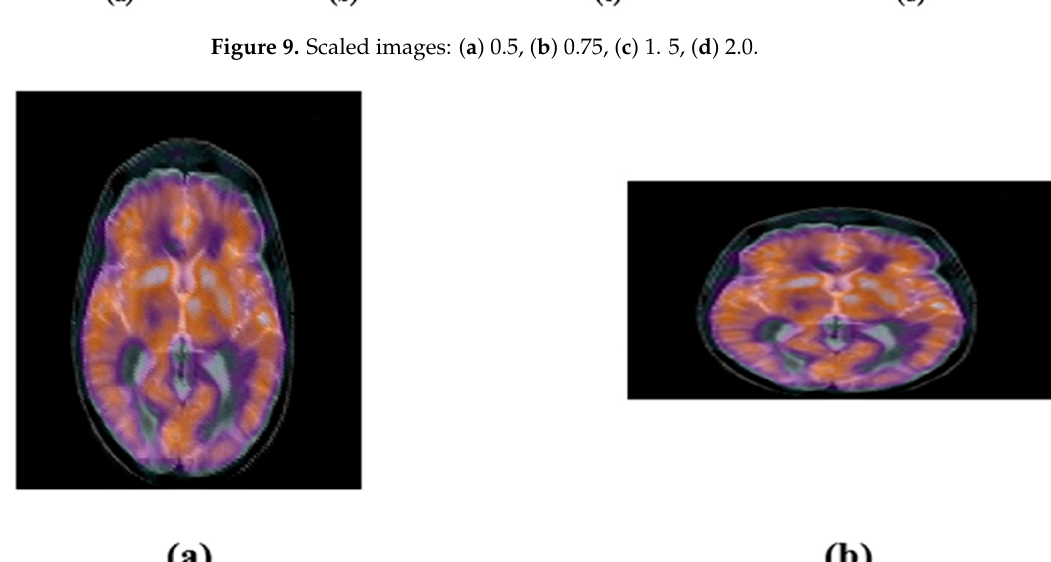
Figure 10. Image after under LWR changing: ( a ) (1.0, 0.75), ( b ) (0.5, 1.0).